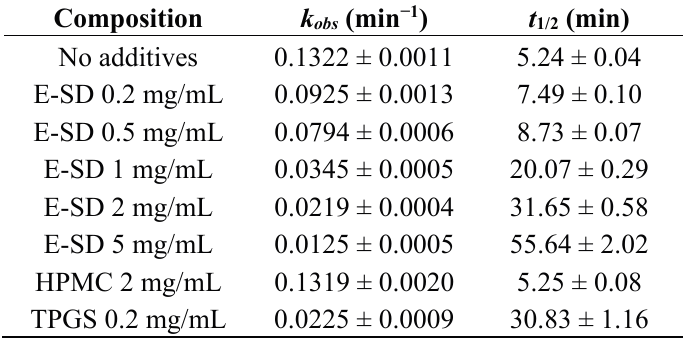
Table 1. Effect of E-SD on the degradation of sirolimus in simulated gastric fluid (pH 1.2).